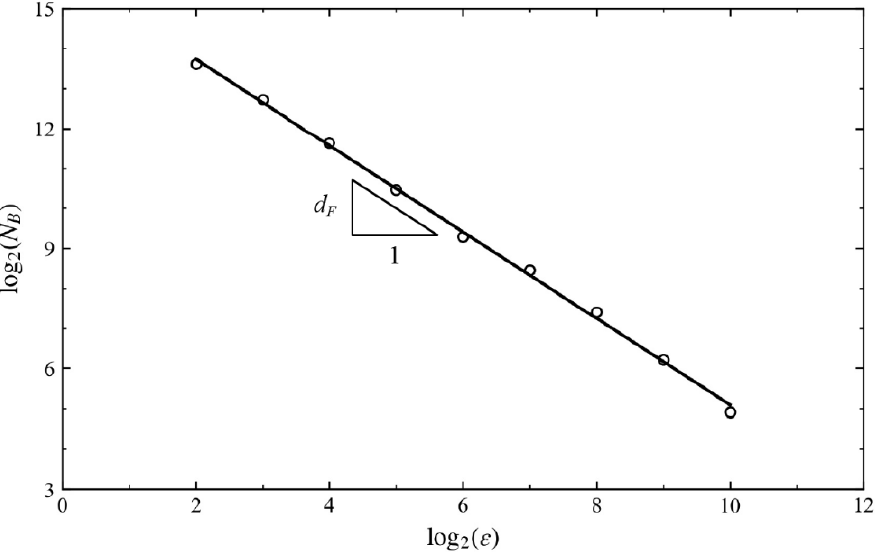
Figure 5. Plot of log 2 𝑁 𝐵 vs. log 2 𝜖 defining the fractality of the fatigue crack.